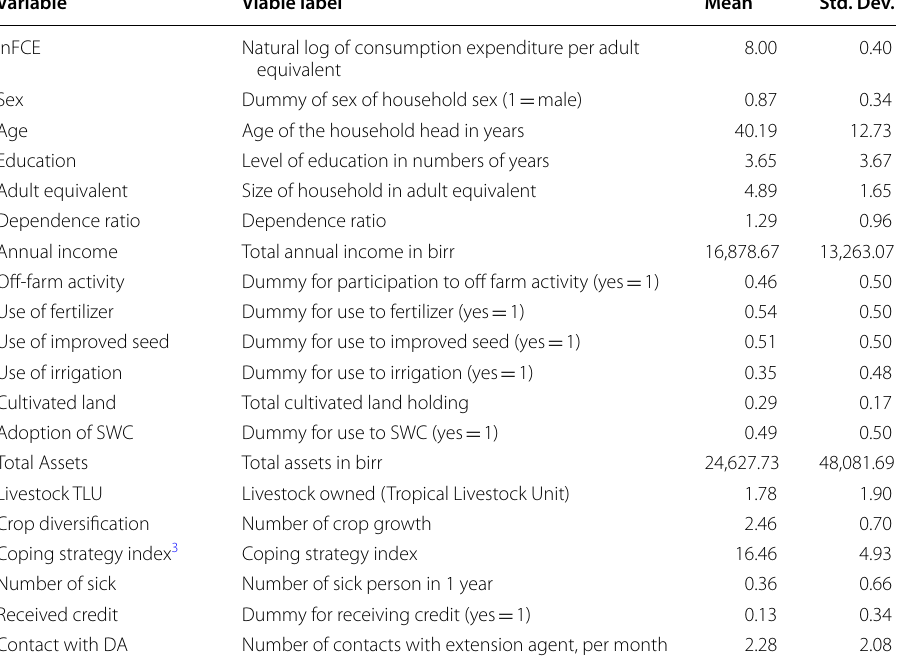
Table 1 Variable specification and summary statistics of household